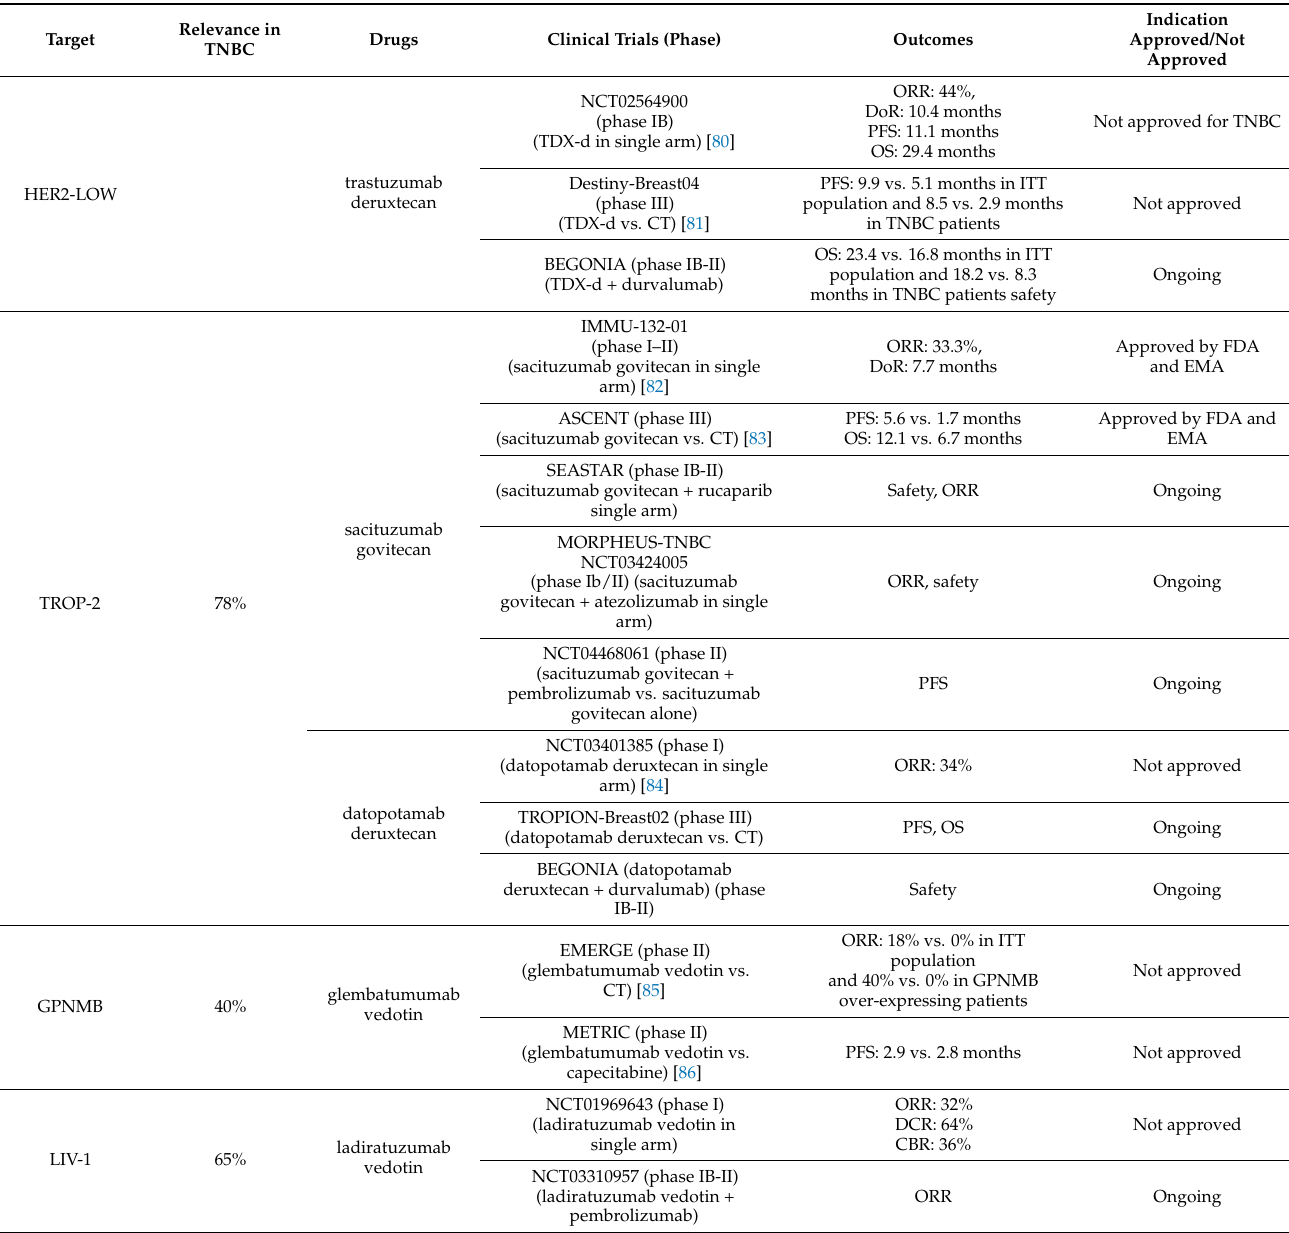
Table 3. ADCs in TNBC: summary of clinical